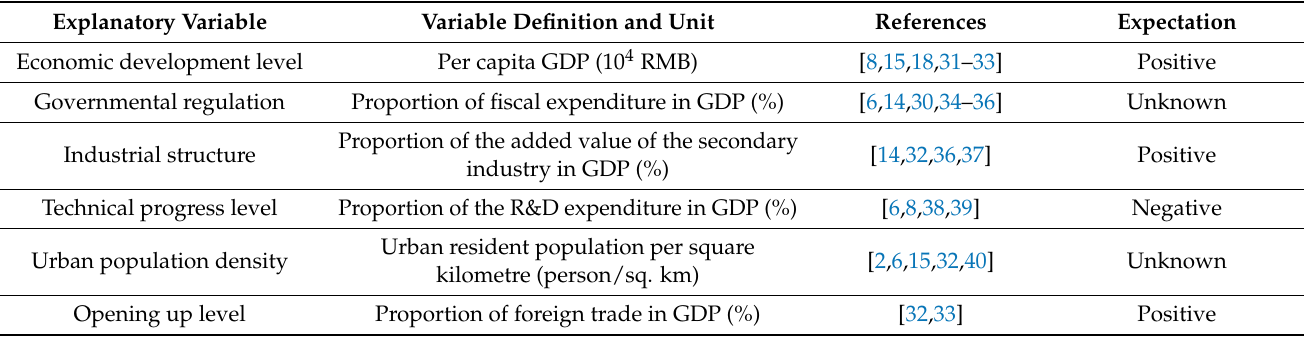
Table 2. ULGUE driving